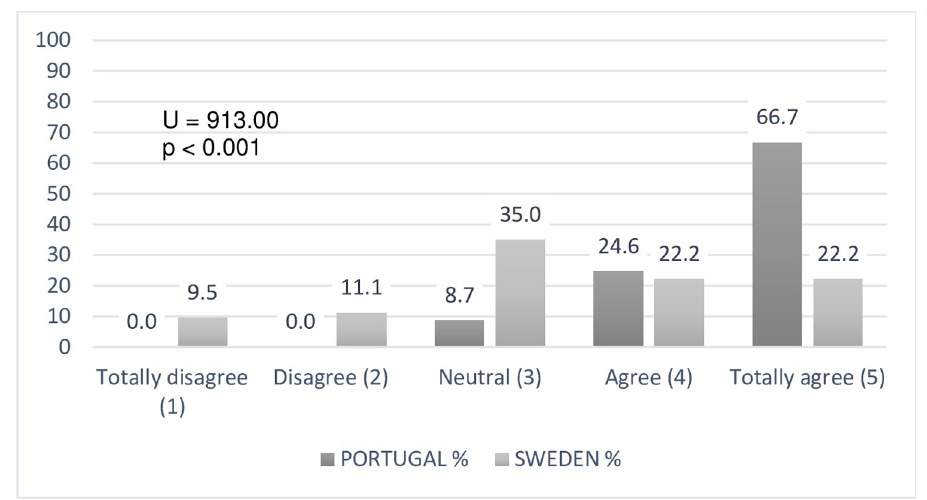
Fig 6. Teachers’ conceptions about the importance given to the visual material exhibition in classroom walls (N = 133).